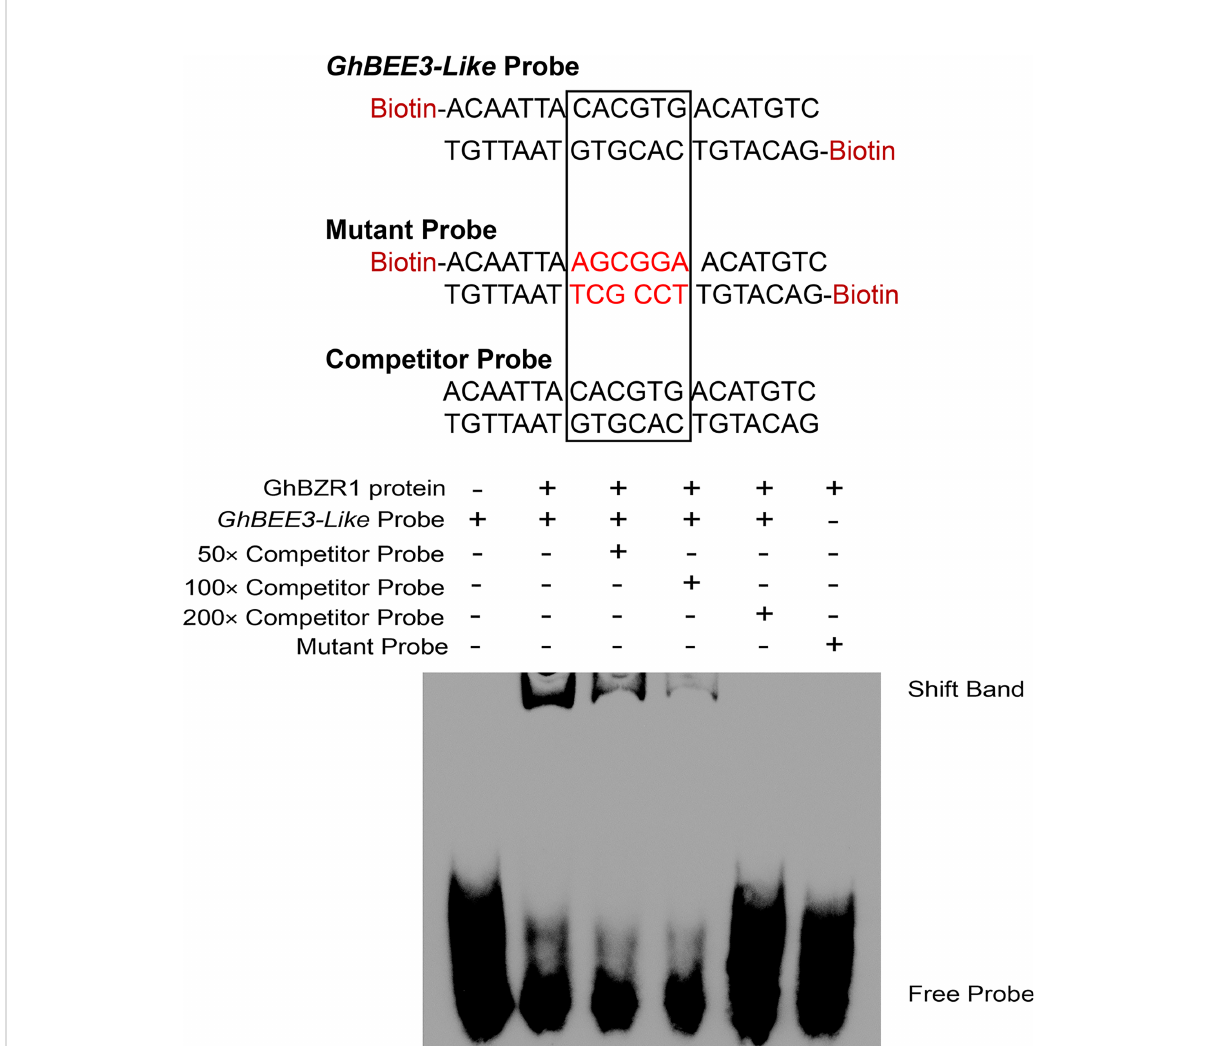
FIGURE 4 The EMSA (electrophoretic mobility shift assay) displaying the interaction between GhBZR1, a key TF in BR signaling pathway, and the E-box element in GhBEE3-Like